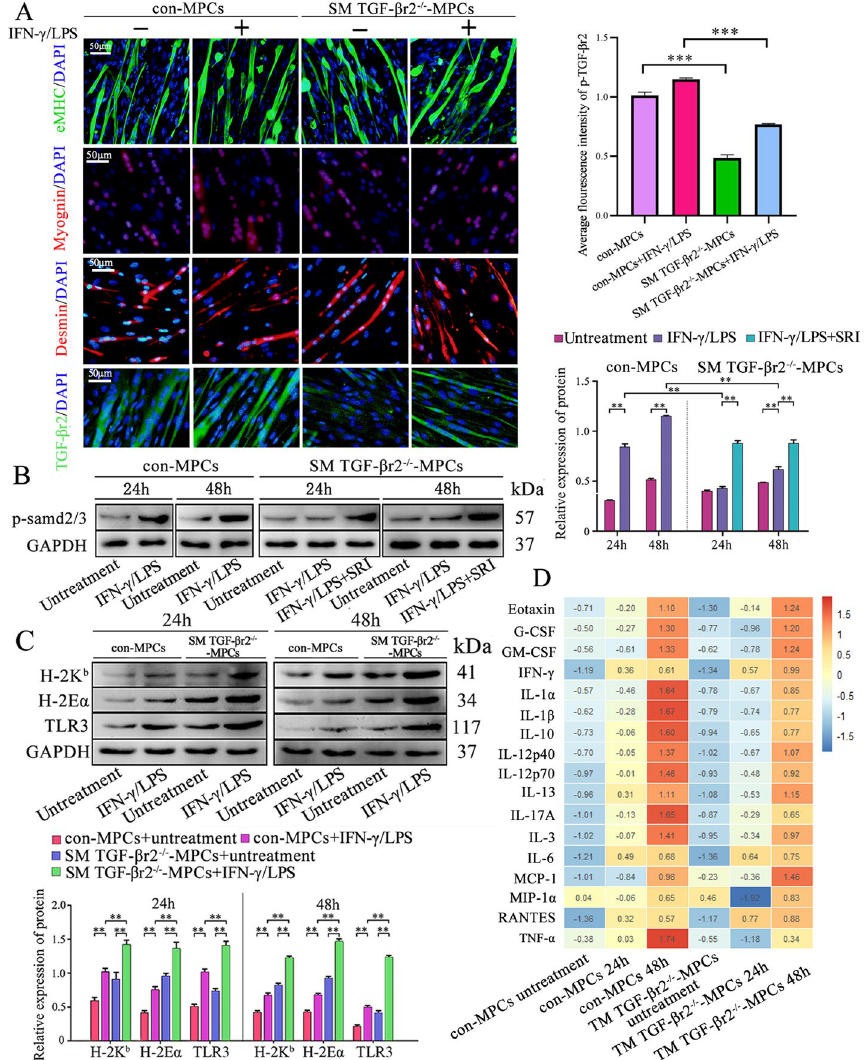
Fig. 3 Intrinsic TGF-β signal controls immunological molecules and myokine expression in cultured primary myotubes. A Representative immunofluorescence staining for desmin, myogenin, eMHC, and TGF-βr2 in SM TGF-βr2 − / − mice-derived MPC-myotubes (MPCs) that received pro-inflammatory stimuli or not. B , C Western blot analysis of the protein expression of p-Smad2/3, H-2K b , H2-Eα, and TLR3 in MPC-myotubes that received pro-inflammatory stimuli or not. D Luminex assay of protein level changes for pro-inflammatory myokines in control or SM TGF-βr2 − / − mice-derived MPC-myotubes exposed to inflammatory milieu or not. Before creating the heat map, log transformation was used to process the data and plot in R language. The relative protein levels are expressed as a ratio (protein of interest/GAPDH). All data are presented as means ( n 3 replicates). One-way ANOVA was used for multiple comparisons (** P < 0.01; *** P < 0.001). Bar =